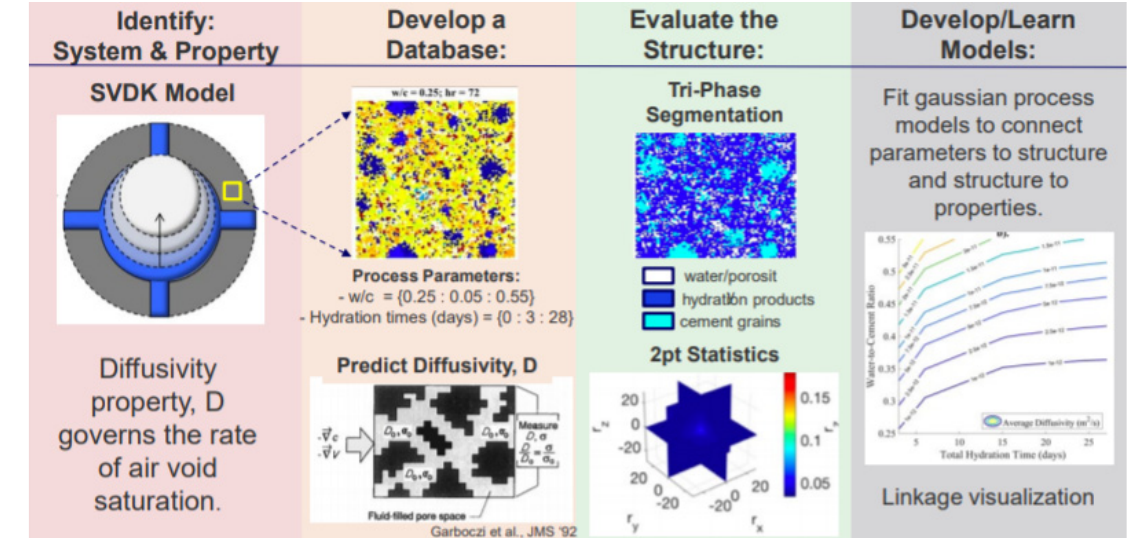
Figure 5 . Workflow of the process ‐ structure ‐ property linkages to model time to critical saturation in cement pastes [41].